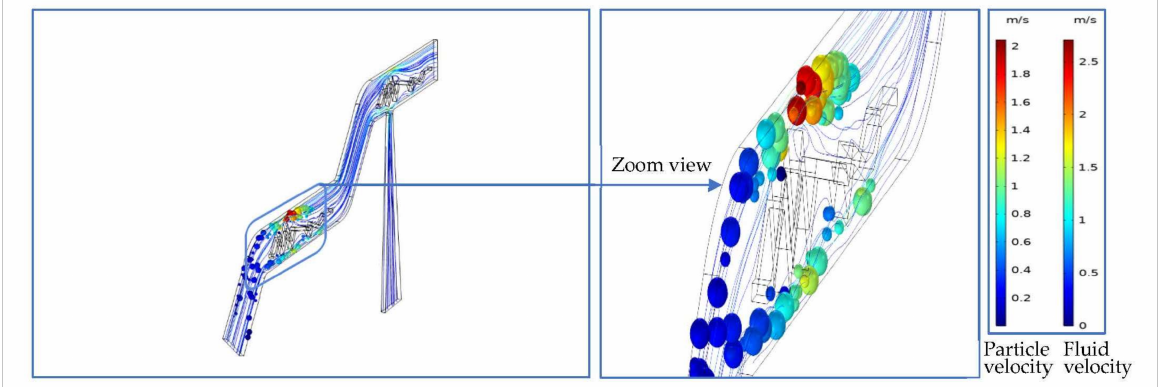
Figure 12. 3D view of corrugated dragonfly wing microchip at 0.004 s.